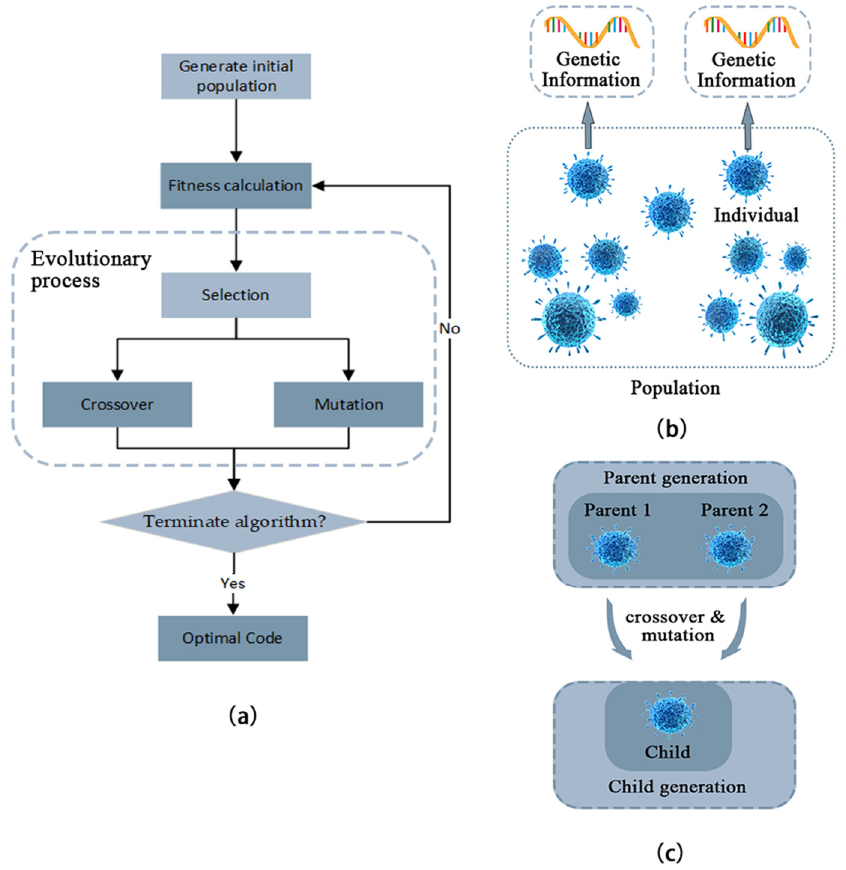
Figure 2. FSND-ENN principle diagram. ( a ) Flowchart of genetic algorithm. ( b ) Relationship between populations, individuals, and genotypes. ( c ) Relationship between parent generation, parent, child generation, and